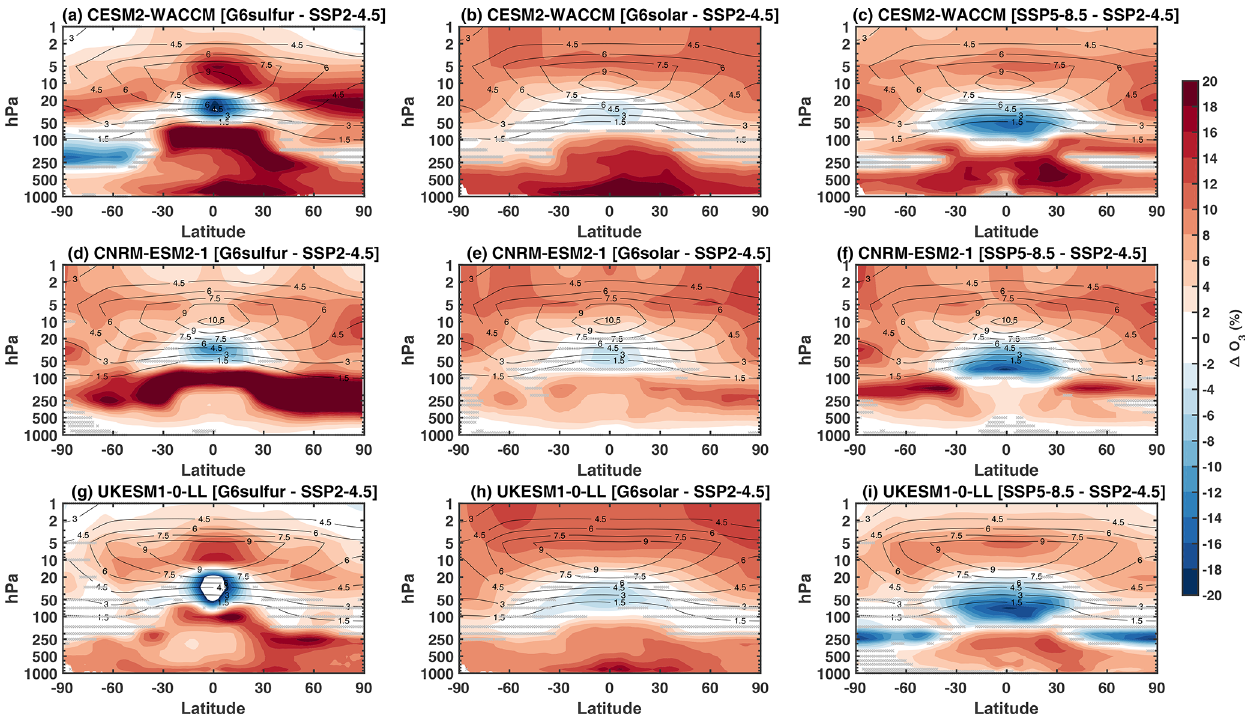
Figure A4. Ozone concentration changes (%) between G6sulfur and SSP2-4.5 (a, d, g) , G6solar and SSP2.-45 (b, e, h) , and SSP5-8.5 and SSP2-4.5 (c, f, i) in the 2080–2099 period. Contour lines show the SSP2-4.5 ozone concentration over the same period. Gray horizontal lines indicate changes that are not statistically significant over the temporal period considered when using a double-sided t test at 95% confidence